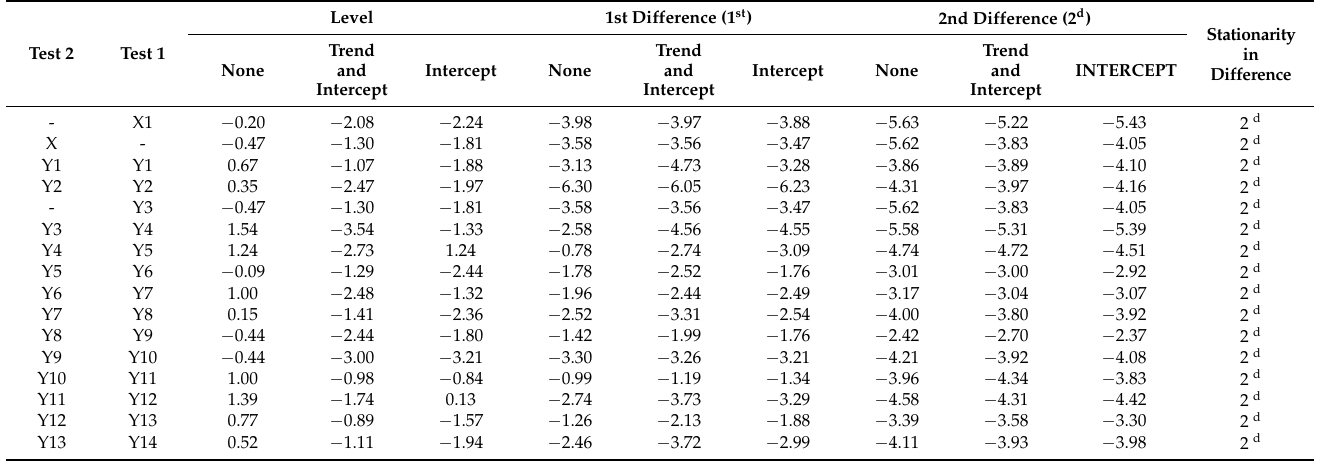
Figure 4. The residual-based ADF test for Test 2. The graphs show that the residuals were almost stable. To ensure that the residuals were stable at the first level (i.e., the time series did not contain a unit root), we applied the augmented Dickey–Fuller (ADF) test, for which the results are shown in Tables 2 and 3.